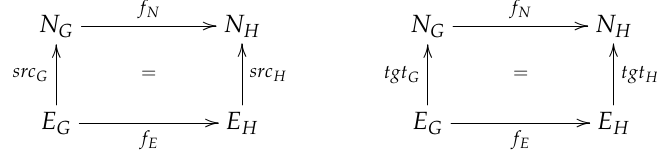
Figure 5. Graph morphism between (directed)